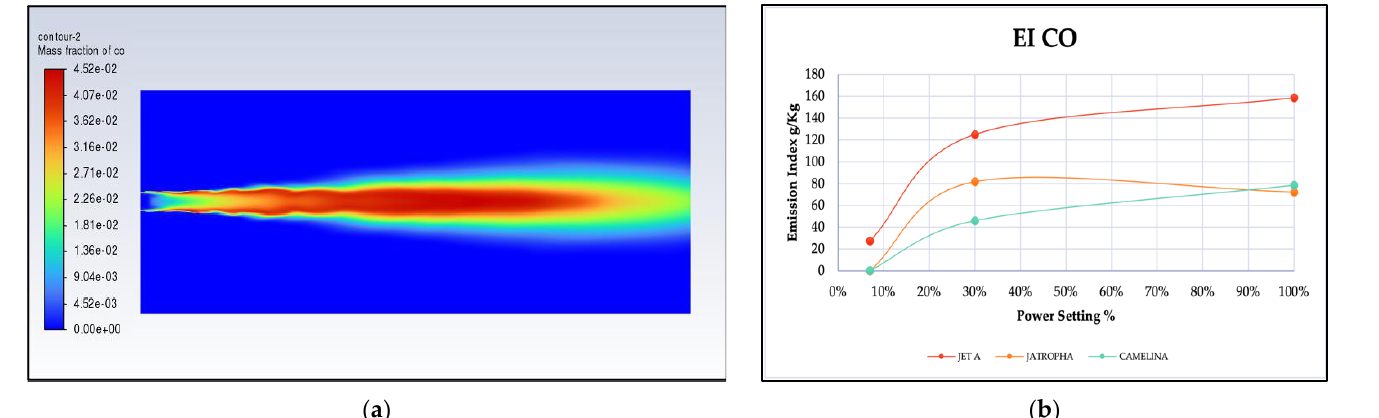
Figure 8. CO emission’s simulation results from camelina biofuel combustion : ( a ) the contour of the CO compound mass fraction released while burning camelina at 100% power; ( b ) the emission index of CO versus the power setting for the simulated fuels.